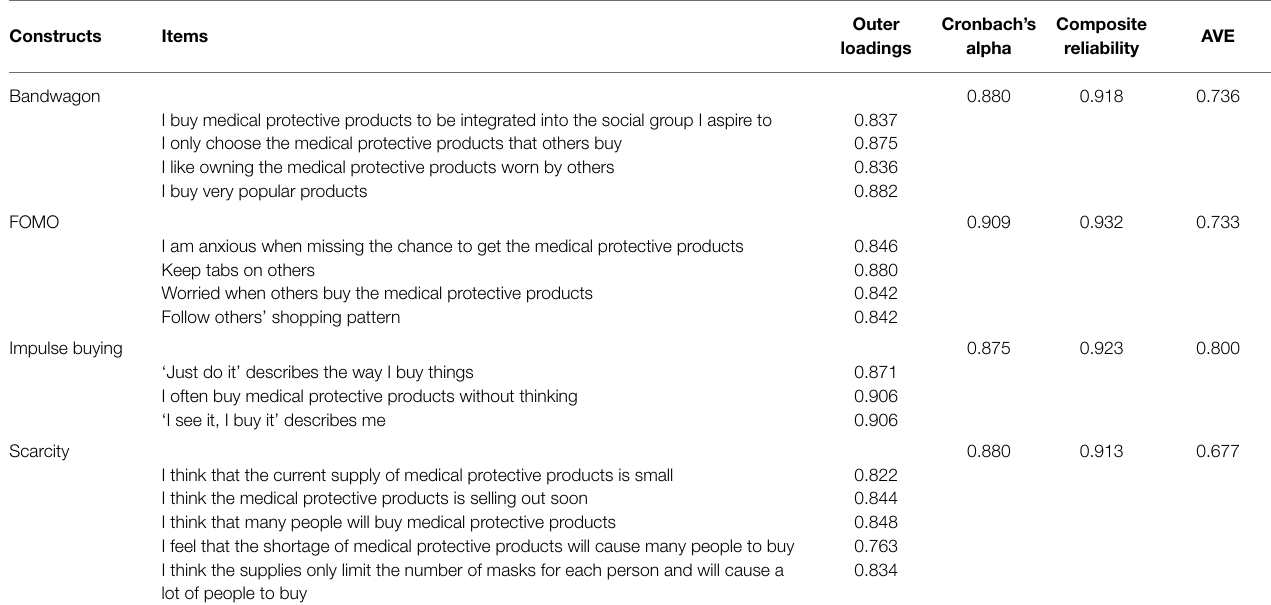
TABLE 3 | Measurement model